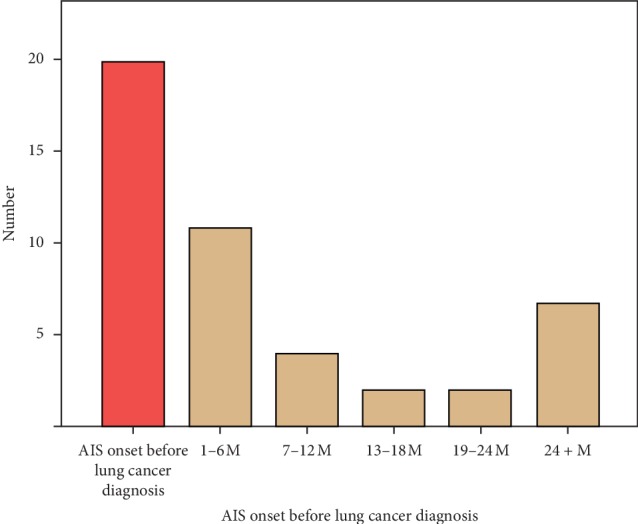
Relationship between lung cancer and AIS onset time in patients with LCA-AIS.